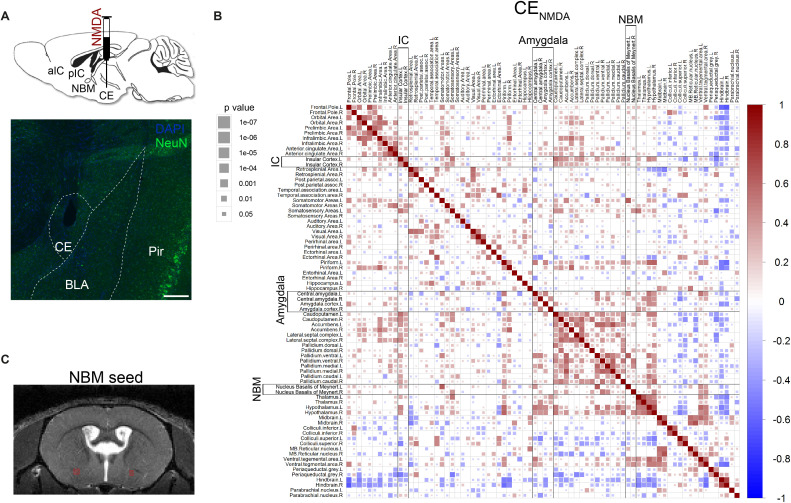
ROI-based functional connectivity of the CE lesion group.(A) (top) Mice received a bilateral injection of NMDA (N-methyl-D-aspartate, CENMDA, n = 3) or saline (CESHAM, n = 4, Figure 1A and see Figure 1—figure supplement 1) into CE. (bottom) Representative staining with NeuN from a mouse from the CENMDA group. scalebar = 100 µm. BLA – basolateral amygdala, Pir – piriform cortex. (B) Functional connectivity in the CENMDA group with significant (one sample t-test, p<0.05) Fisher z-transformed Pearson correlation coefficients between each pair of brain regions (blue-to-red scale) are shown (significance of correlations reflected by the size of the square). (C) Seed region mask used for functional connectivity of the NBM in Figure 4B.Figure 4—figure supplement 1—source data 1.fMRI cross-correlation matrix of CENMDA in Figure 4—figure supplement 1B.